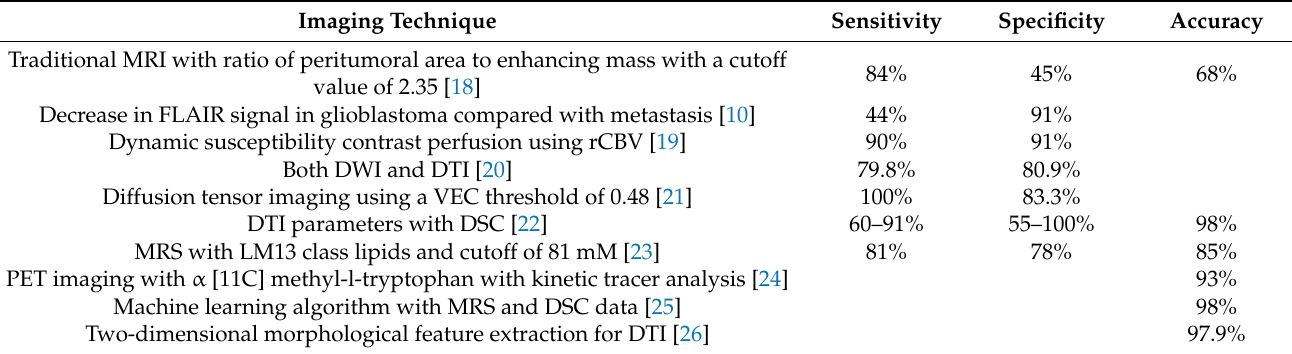
Table 1. Sensitivities and specificities of advanced imaging modalities for differentiating glioblastoma versus metastasis. Imaging Technique Sensitivity Specificity